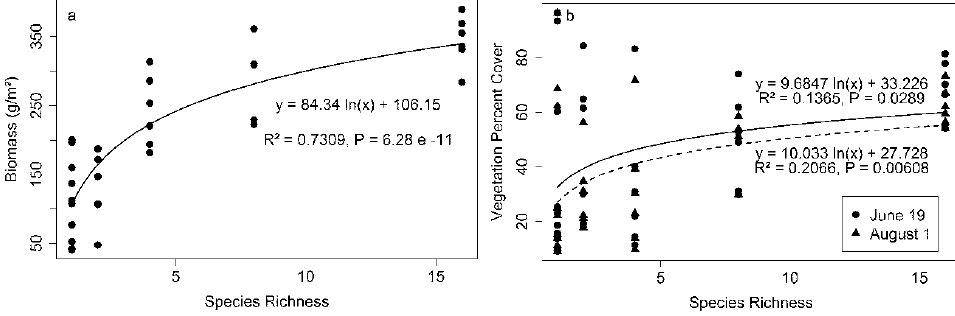
Figure 3. Species richness versus biomass ( a ) and vegetation percent cover ( b ). Biomass was measured on 4 August and percent cover was measured on 19 June and 1 August 2014.